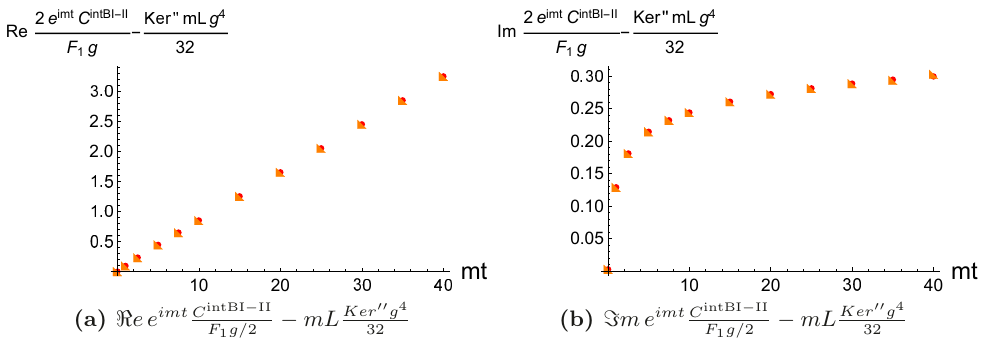
′′ g 4 mL Ker calculated with a discrete sum 32 F 1 g/ 2 −